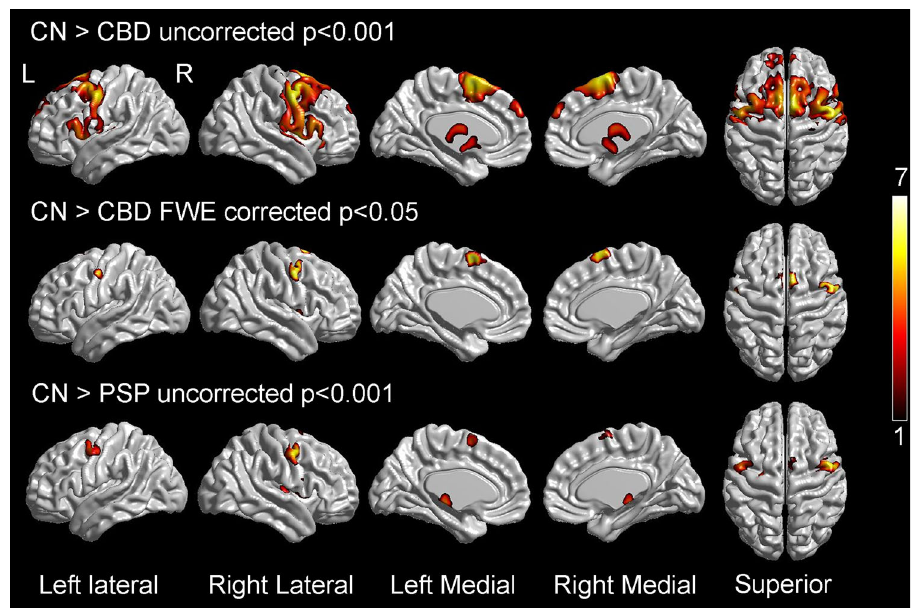
Fig. 3 Voxel-level FDG-PET fi ndings at baseline. The top two rows show regions of hypometabolism in progressive apraxia of speech patients with corticobasal degeneration (CBD) compared to controls, either uncorrected for multiple comparisons at p < 0.001 (top) or after correction for multiple comparisons using family-wise error (FWE) correction at p < 0.05 (middle). The bottom row shows regions of hypometabolism in progressive apraxia of speech patients with progressive supranuclear palsy (PSP) compared to controls shown uncorrected for multiple comparisons at p < 0.001. Statistical comparisons were performed using two-sided t -tests in SPM12. Color scale re fl ects T score. Results are shown on three-dimensional brain renderings using BrainNet Viewer.